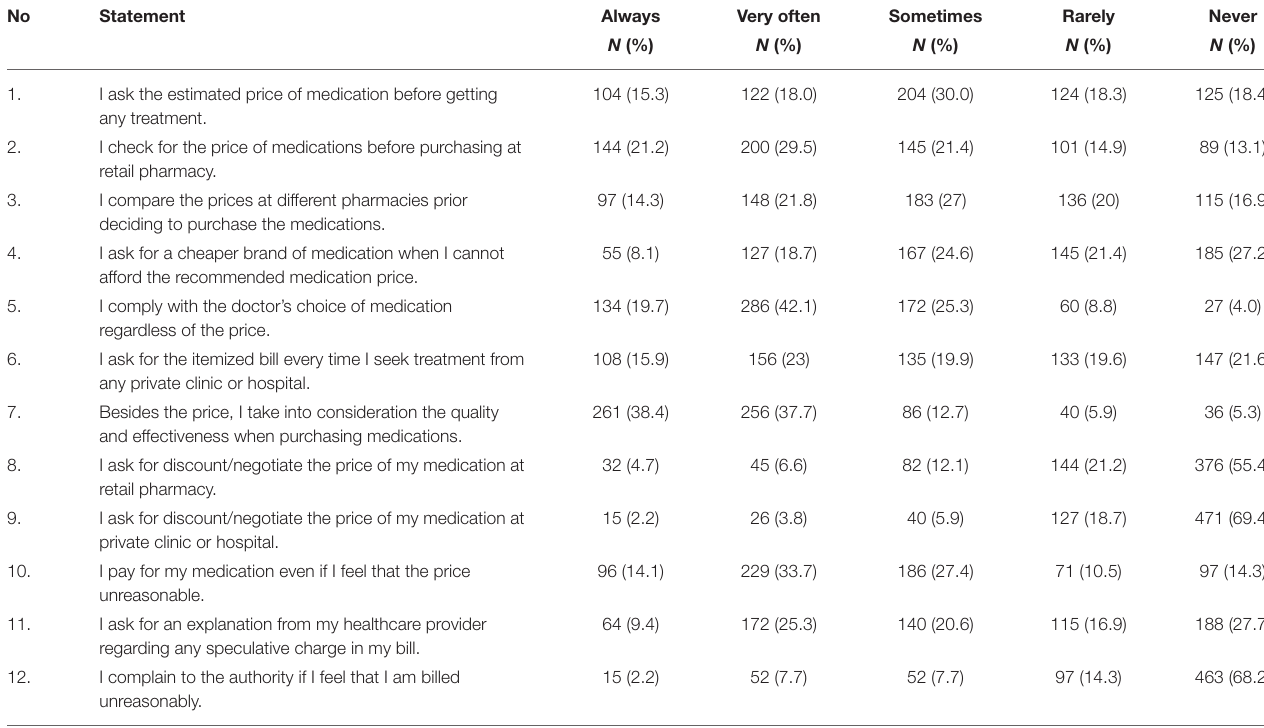
TABLE 4 | Respondents’ practice on medicine price transparency practice in private healthcare setting in